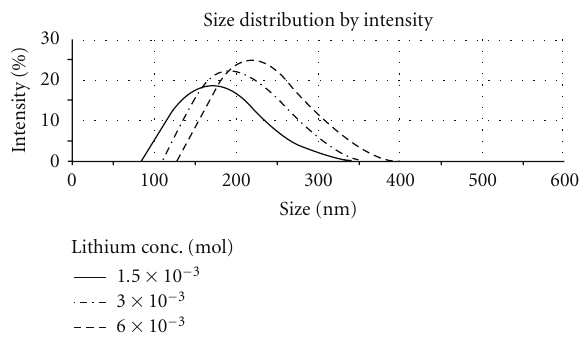
Figure 7: Particle size distributions at di ff erent lithium ion concentrations (copper ion concentration is held constant at 0.3 × 10 − 3